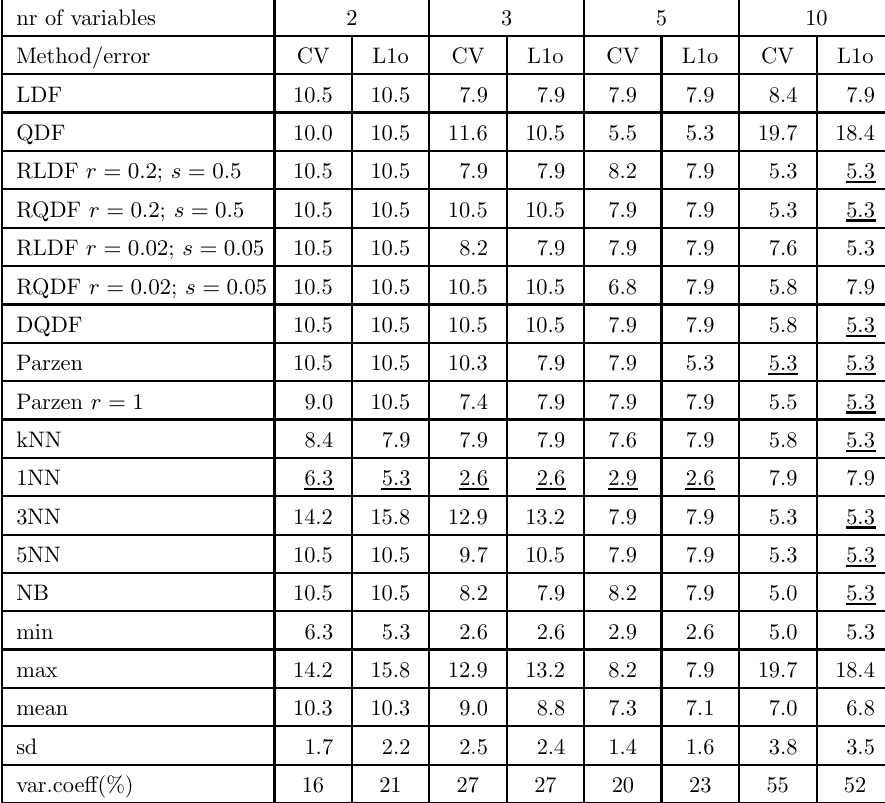
Table 2. Generalization errors (*100%) of single classifiers for 2, 3, 5 and 10 selected